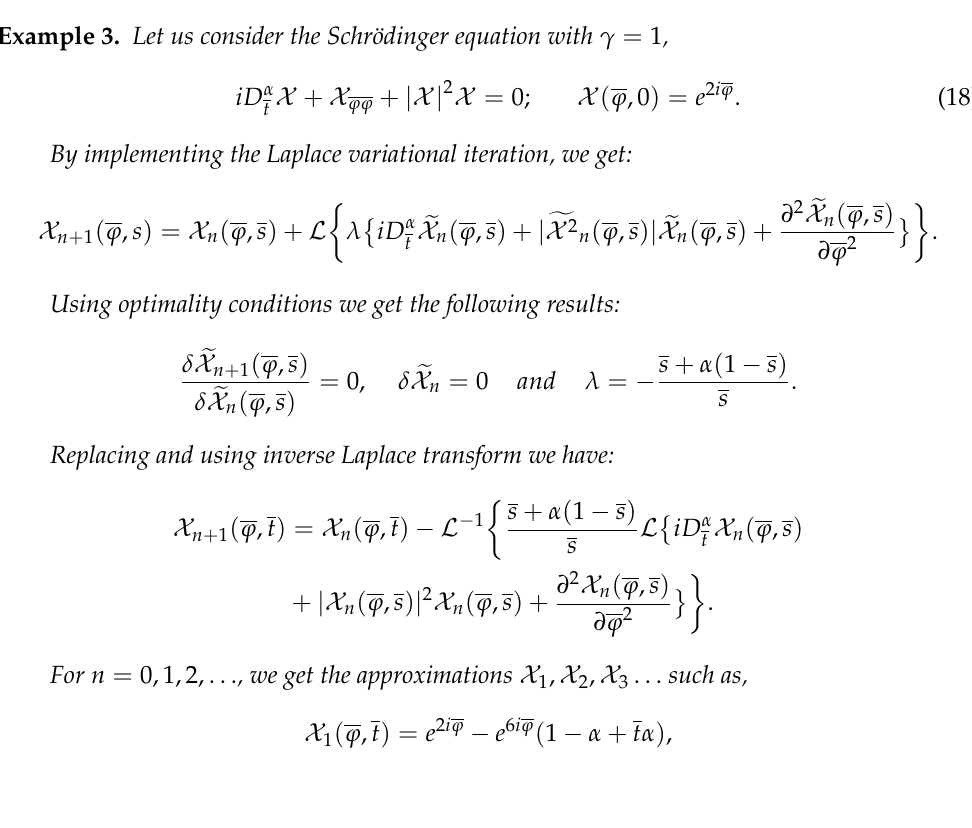
Figure 4. Three dimensional (3D) display of X ( ϕ , t ) for α = 0.5—( a ), α = 1—( b ) and the exact solution—( c